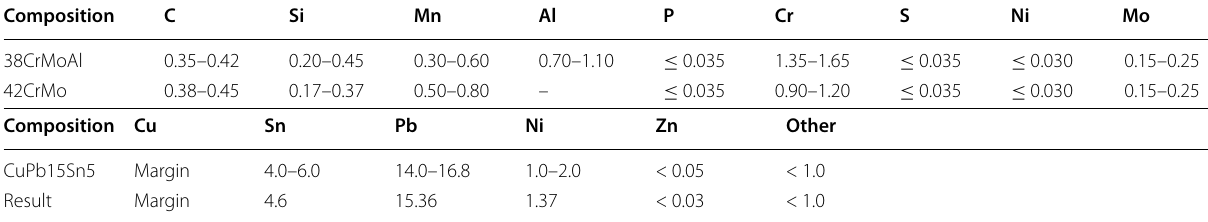
Table 1 Material composition of the specimens (%)